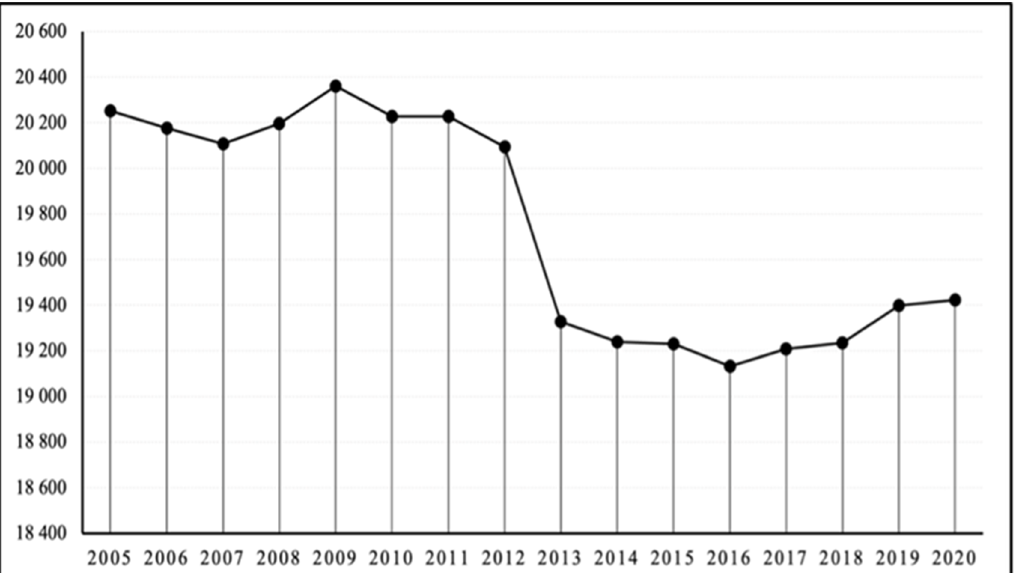
Figure 4. Length of operated railway lines in Poland in the years 2005–2020 in km (own study, based on